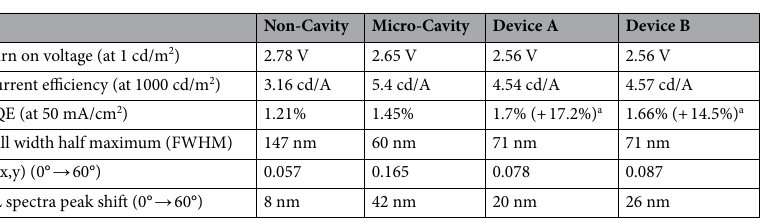
Table 3. Summary of device characteristics. a Efficiency enhancement ratio when compared to that of the Micro-Cavity